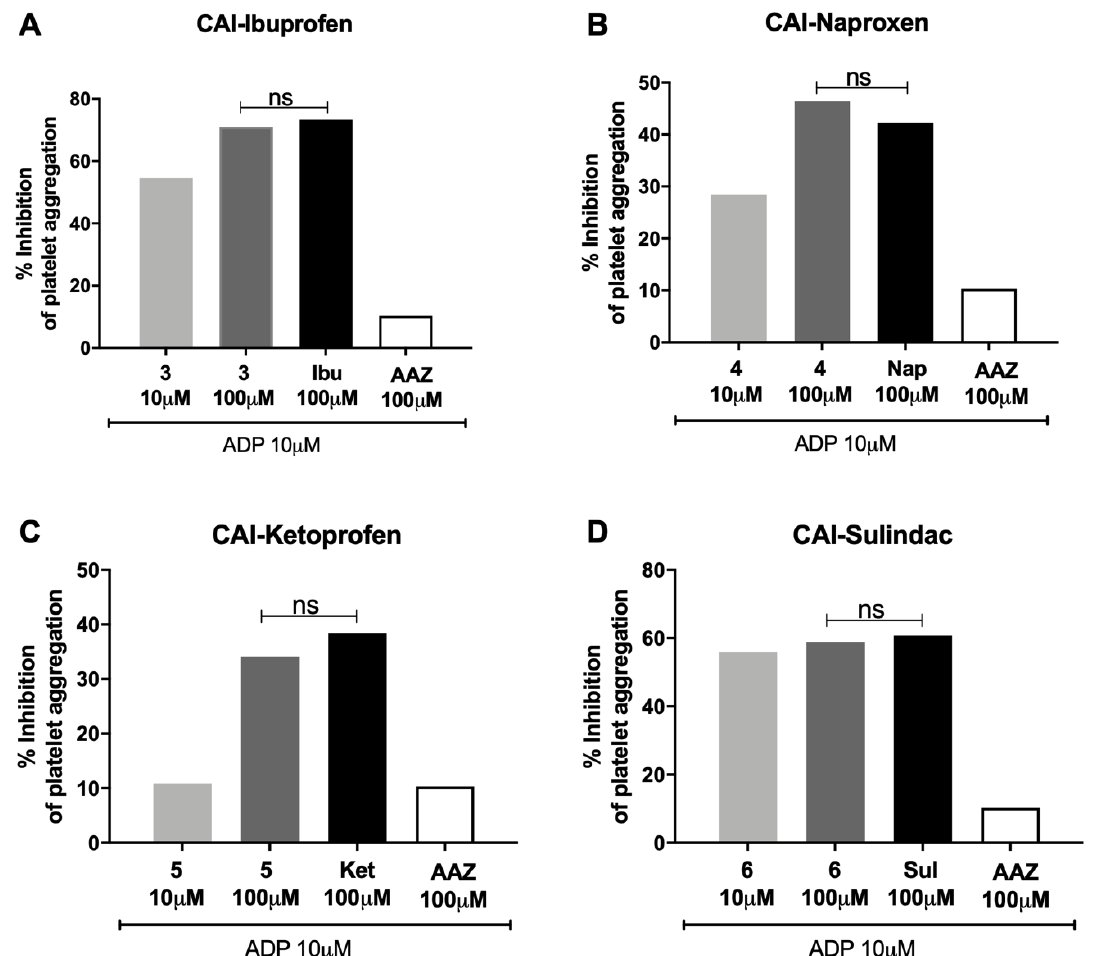
Figure 3. Percentage inhibition of platelet aggregation. Effects of different concentrations of ( A ) CAI-ibuprofen, ( B ) CAI-naproxen, ( C ) CAI-ketoprofen and ( D ) CAI-sulindac after 5 min of ADP (10 µM) incubation in human platelet-rich plasma (PRP). Platelet aggregation baseline is 79.37%, corresponding to 100% of aggregation. Values represent the mean ± SEM of 8 independent experiments, (ns = non-significant between selected columns).